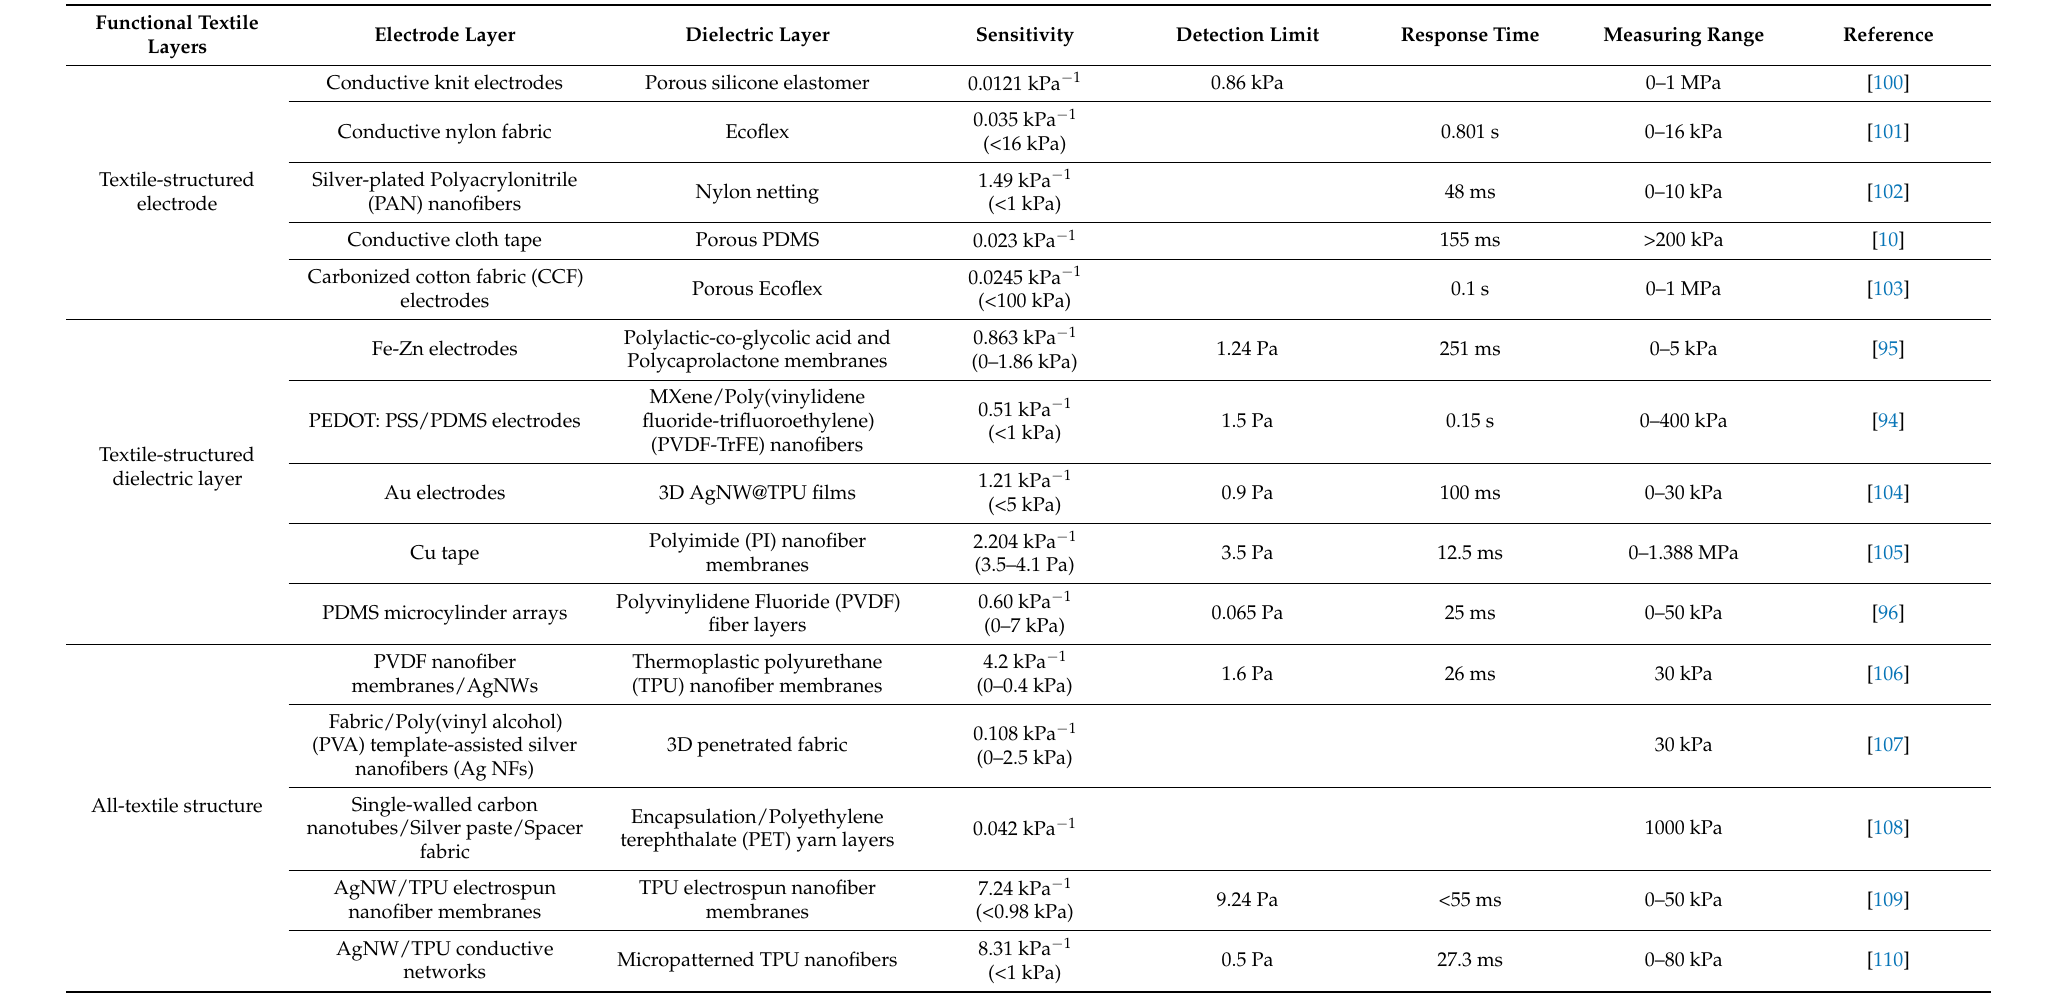
Table 2. Performance comparison of capacitive pressure sensors with different textile